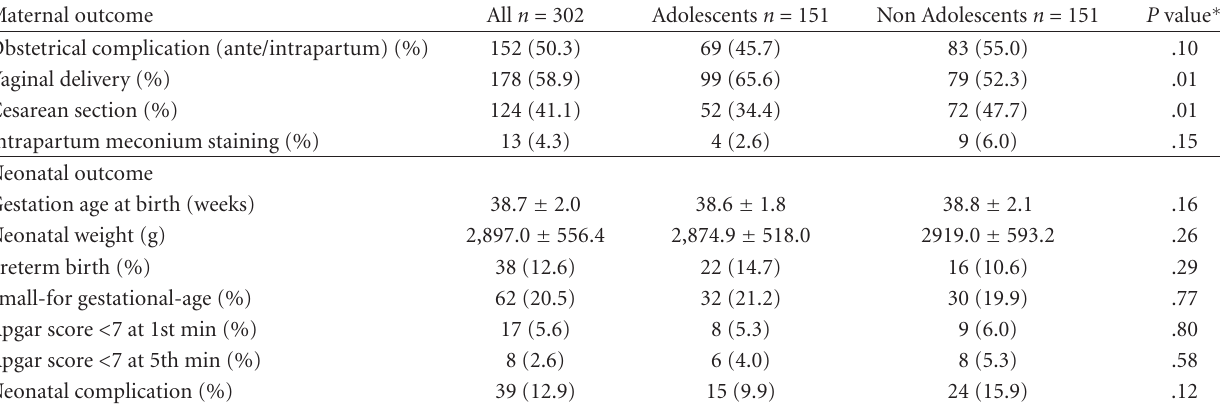
Table 2: Maternal and neonatal outcome data.